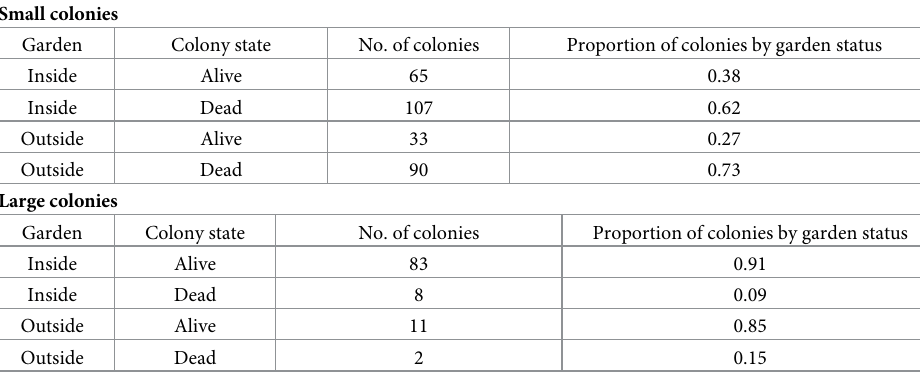
Outside 0.15 The proportions of live and dead large colonies (‘colony state’) after one year as a function of colony size and farmerfish garden status.